Question: Draft a figure caption describing what is shown.
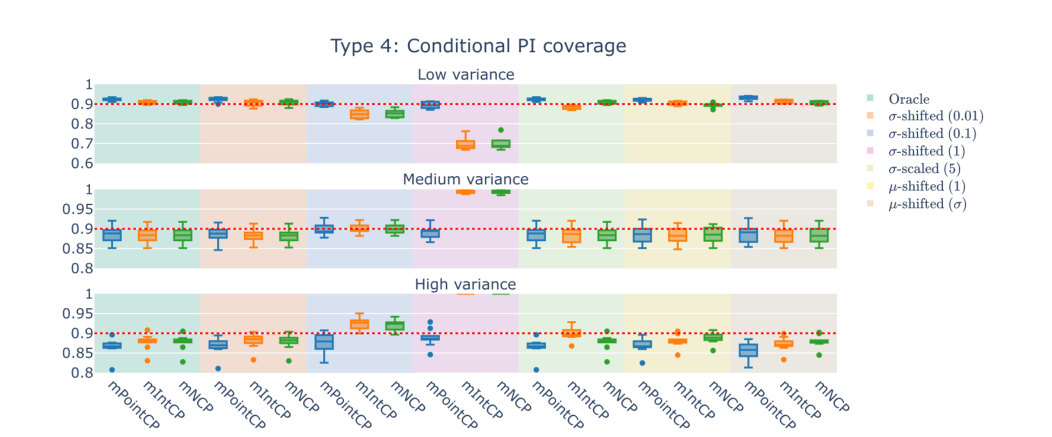
Answer: Conditional coverage at significance level α = 0.1 for a synthetic data set of Type 4. The data is divided in three folds based on equal-frequency binning of the estimated variance. The coloured columns indicate the type of misspecification (from left to right): oracle, additive noise for the standard deviation (means of 0.01, 0.1 and 1), scaling by factor 5 of the standard deviation and additive noise for the mean (means of 1 and bσ). For every model, three nonconformity measures are shown (from left to right): residual, interval and bσ-normalized nonconformity measure.